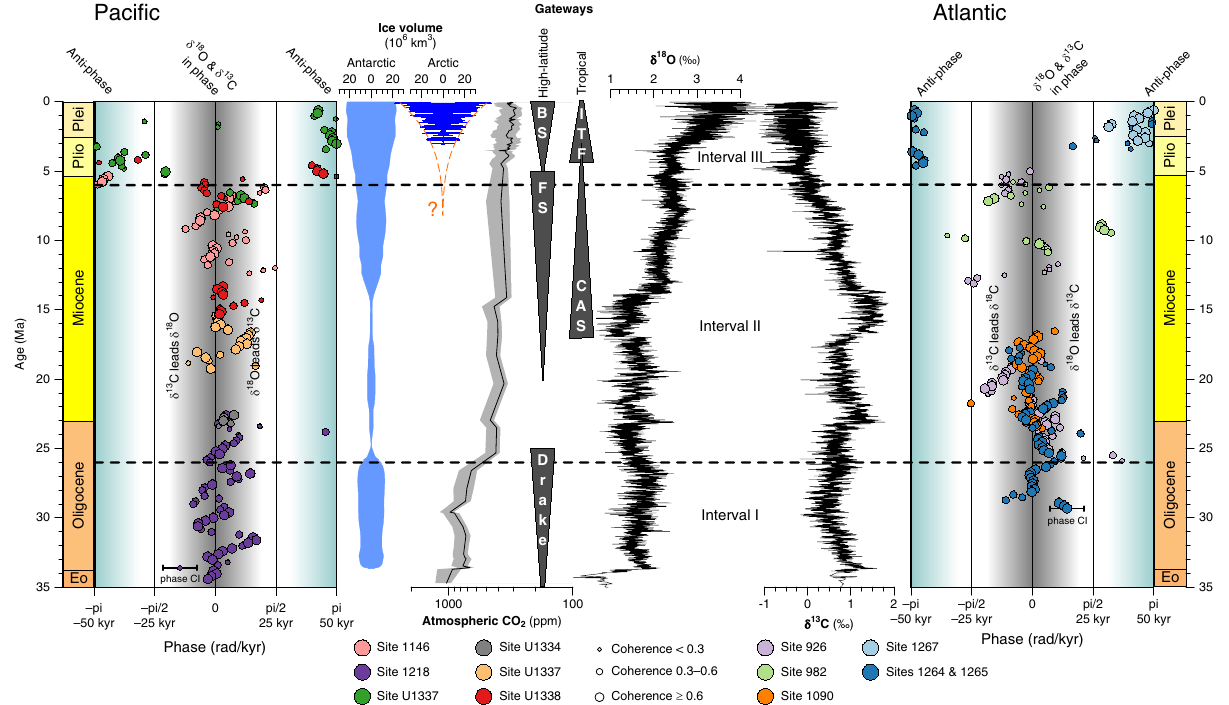
Fig. 2 Phase-relationship between δ 13 C and δ 18 O on 100-kyr eccentricity time-scales. On eccentricity time-scales, δ 13 C and δ 18 O exhibit cyclic in-phase behaviour from 35 till ~6 Ma in the Paci fi c, as well as in the Atlantic Ocean (Intervals I and II). Around 6 Ma in the Paci fi c (Interval III), and somewhat later in the Atlantic, we observe an abrupt shift from in-phase to anti-phase behaviour. The plotted uncertainty bar indicates a typical con fi dence interval (CI) on the phase estimate of ±0.44rad. Uncertainty on the phase difference between δ 13 C and δ 18 O is inversely proportional to coherence and overall ranges between ±0.25 and ±0.59 rad. Antarctic and Arctic ice volume reconstructions are from Oerlemans 63 and Berger et al. 80 , respectively. The earlier onset of NH glaciation suggested by this study is indicated in red. Atmospheric CO 2 reconstruction from Zhang et al. 81 . Grey triangles indicate opening and closing of important ocean gateways. BS, Bering Strait; FS, Fram Strait; Drake, Drake Passage; CAS, Central American Seaway; ITF, Indonesian Through fl ow. All Sites that constitute the δ 13 C megasplice are included here (references in Fig. 1) and are complemented by additional orbital-resolution benthic isotope data from Sites 926 82 , 982 83 , 1264/1265 15,49 , U1334 50,84 , U1337 17 and U1338 6,85 (data as time-series in Supplementary Fig.